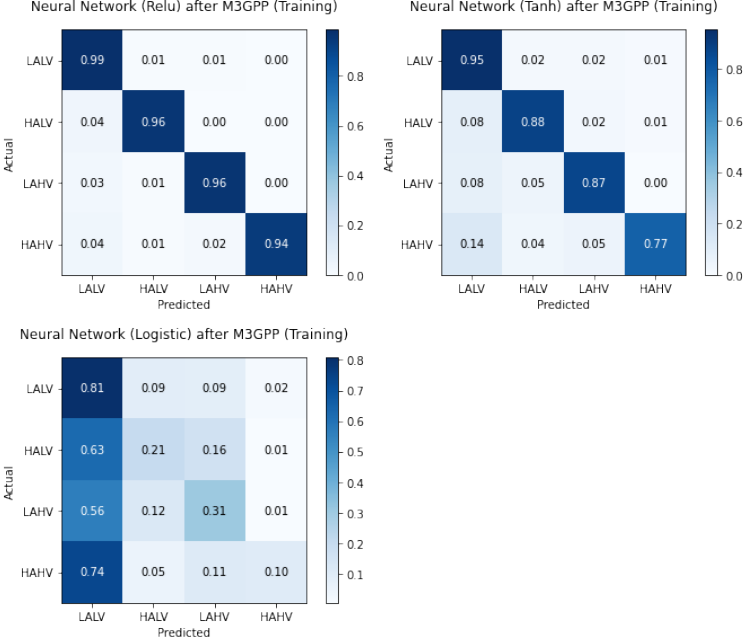
Figure 14. The confusion matrix of the training stages of the reported results obtained after the M3GP transformation for different neural networks (Relu, Tanh and